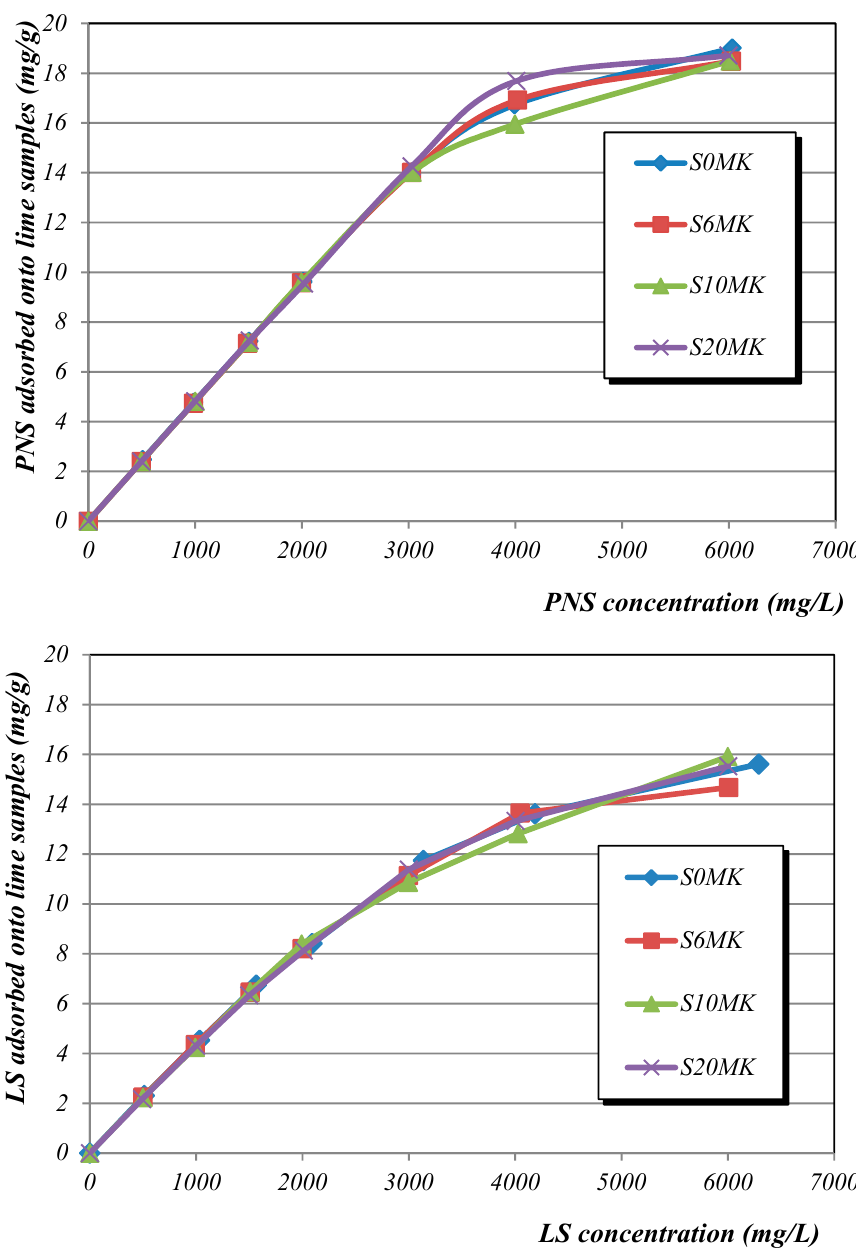
Figure 3. Adsorption isotherms of the SPs onto lime pastes (6, 10, and 20 wt % of pozzolanic admixture). PNS adsorption ( top ); LS adsorption ( bottom ).